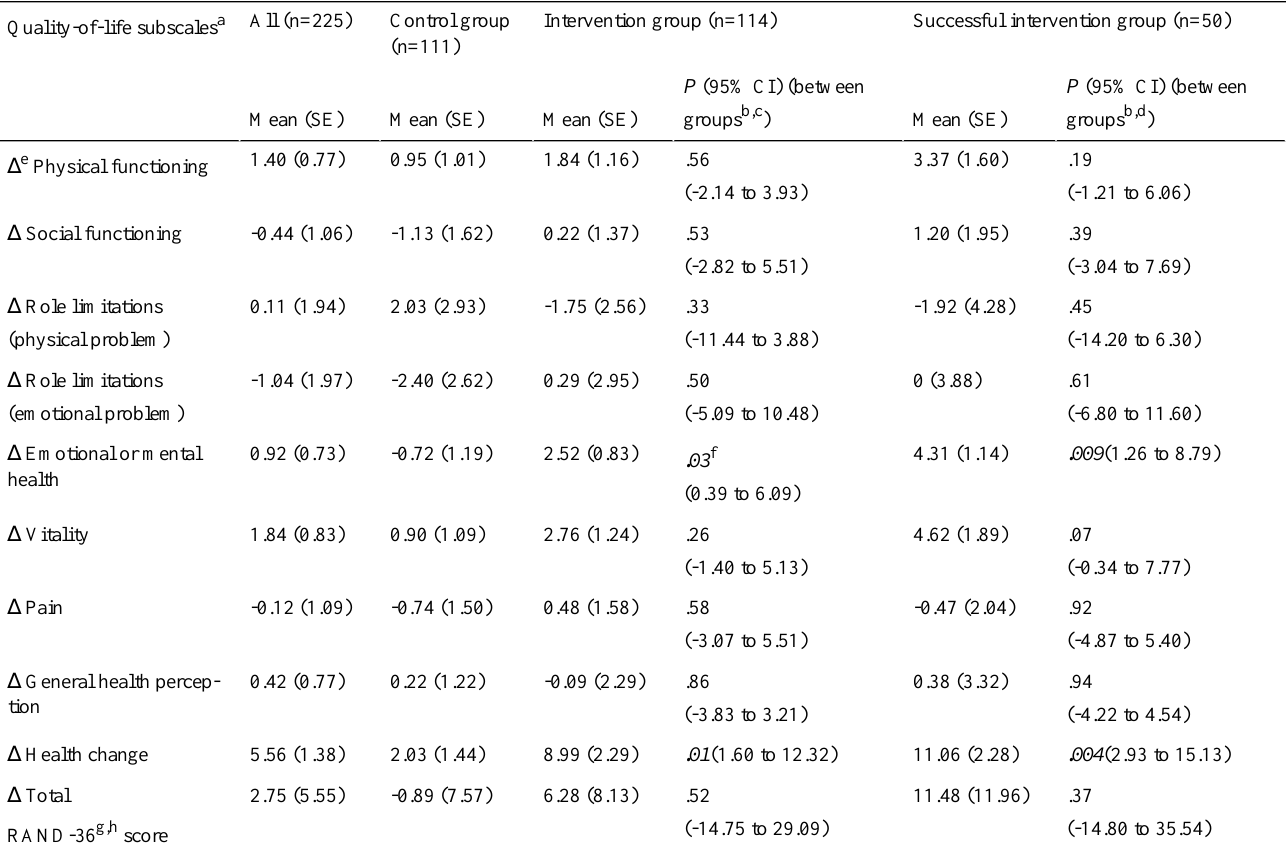
Table 2. Changes in quality of life in the control, intervention, and successful intervention